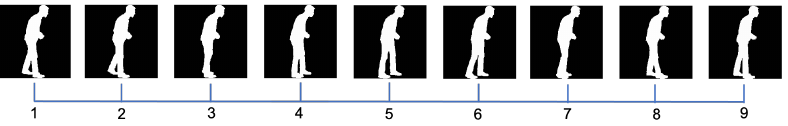
Figure 4. Example of silhouettes in the 9 key frames representing a Parkinsonian gait cycle, extracted according to the proposed key frame selection